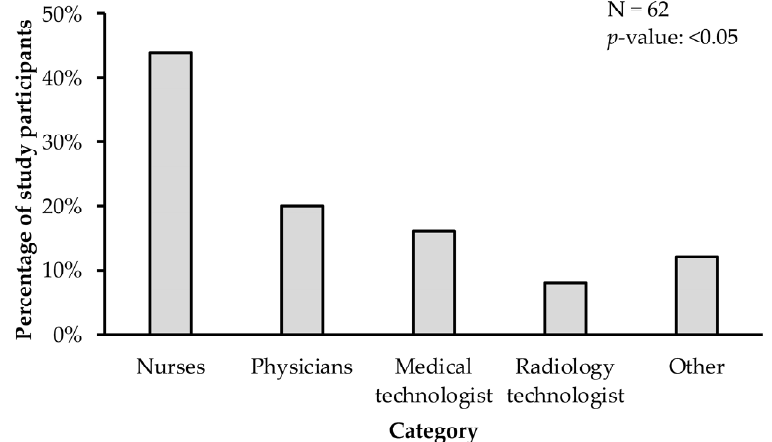
Figure 1. Nurses were among the healthcare workers (HCWs) with a significantly higher risk of exposure to SARS-CoV-2 because of prolonged exposure to a confirmed or suspected case of COVID-19. The proportion of HCWs with medium to high risk of COVID-19 was compared using the proportion Z test. A p -value less than 0.05 was considered